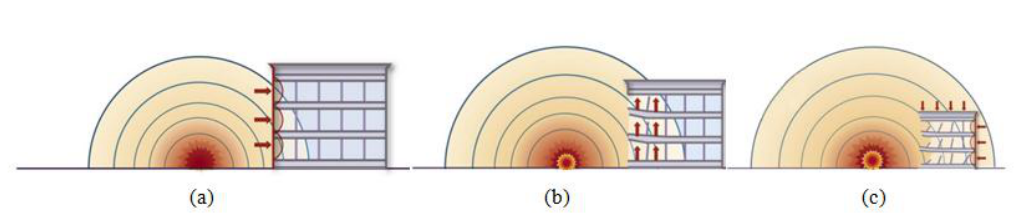
Fig. 4: (a), Blast wave breaks windows structure in columns may be damaged, (b) Blast Wave break by forces floors upward, and (c) Blast wave surrounds structure pressure on all sides